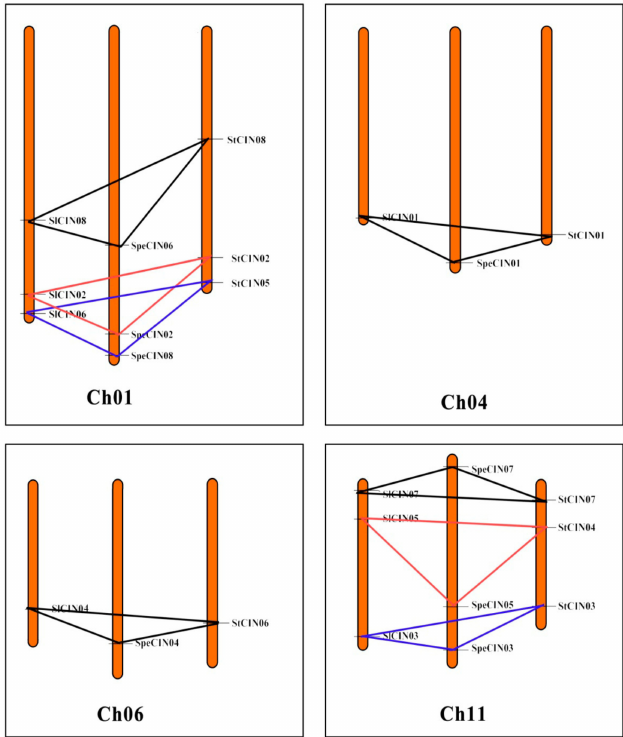
Figure 7. Collinearity relationship of CIN genes from S. lycopersicum , S. pennellii , and S. tuberosum . Collinear gene pairs tied with lines in di ff erent colors. Chromosome numbers shown at the bottom of each